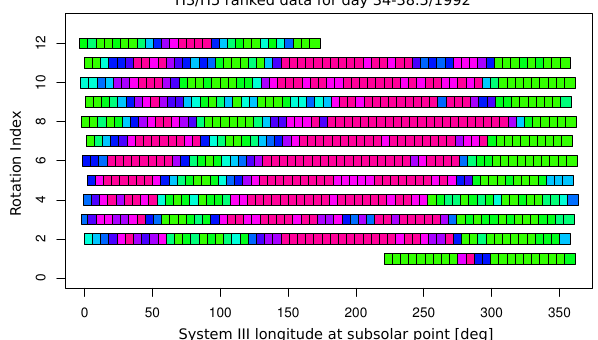
Fig. 6. Local rank structure of the HET H3/H5 ratio from day 34 to 38.5. The time series starts at rotation 1 (bottom) and end with rotation 12 (top). The color code must be interpreted in a way that red squares indicate that the actual data point has a higher rank than its 10 predecessor, while green indicates a lower rank, i.e. the local maxima of the H3/H5 ratio occur when the color switched from red to green. A expected, this is the case a longitudes of about 270 ◦ , re- flecting the major peaks of the Jovian clock. Furthermore, the minor peaks are cleary present with local maxima at 40 − 100 ◦ .